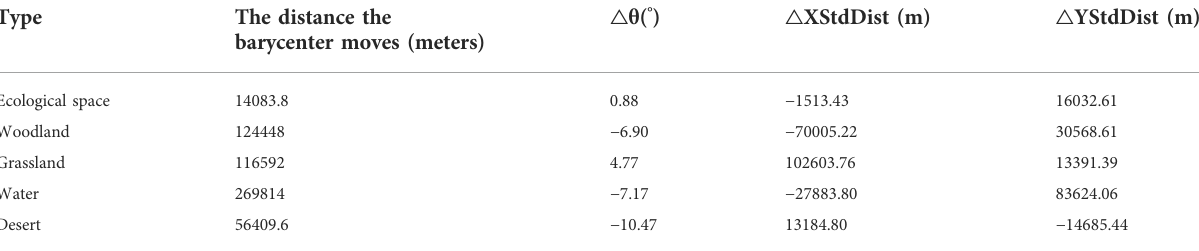
TABLE 7 SDE parameter changes of ecological space types from 2000 to